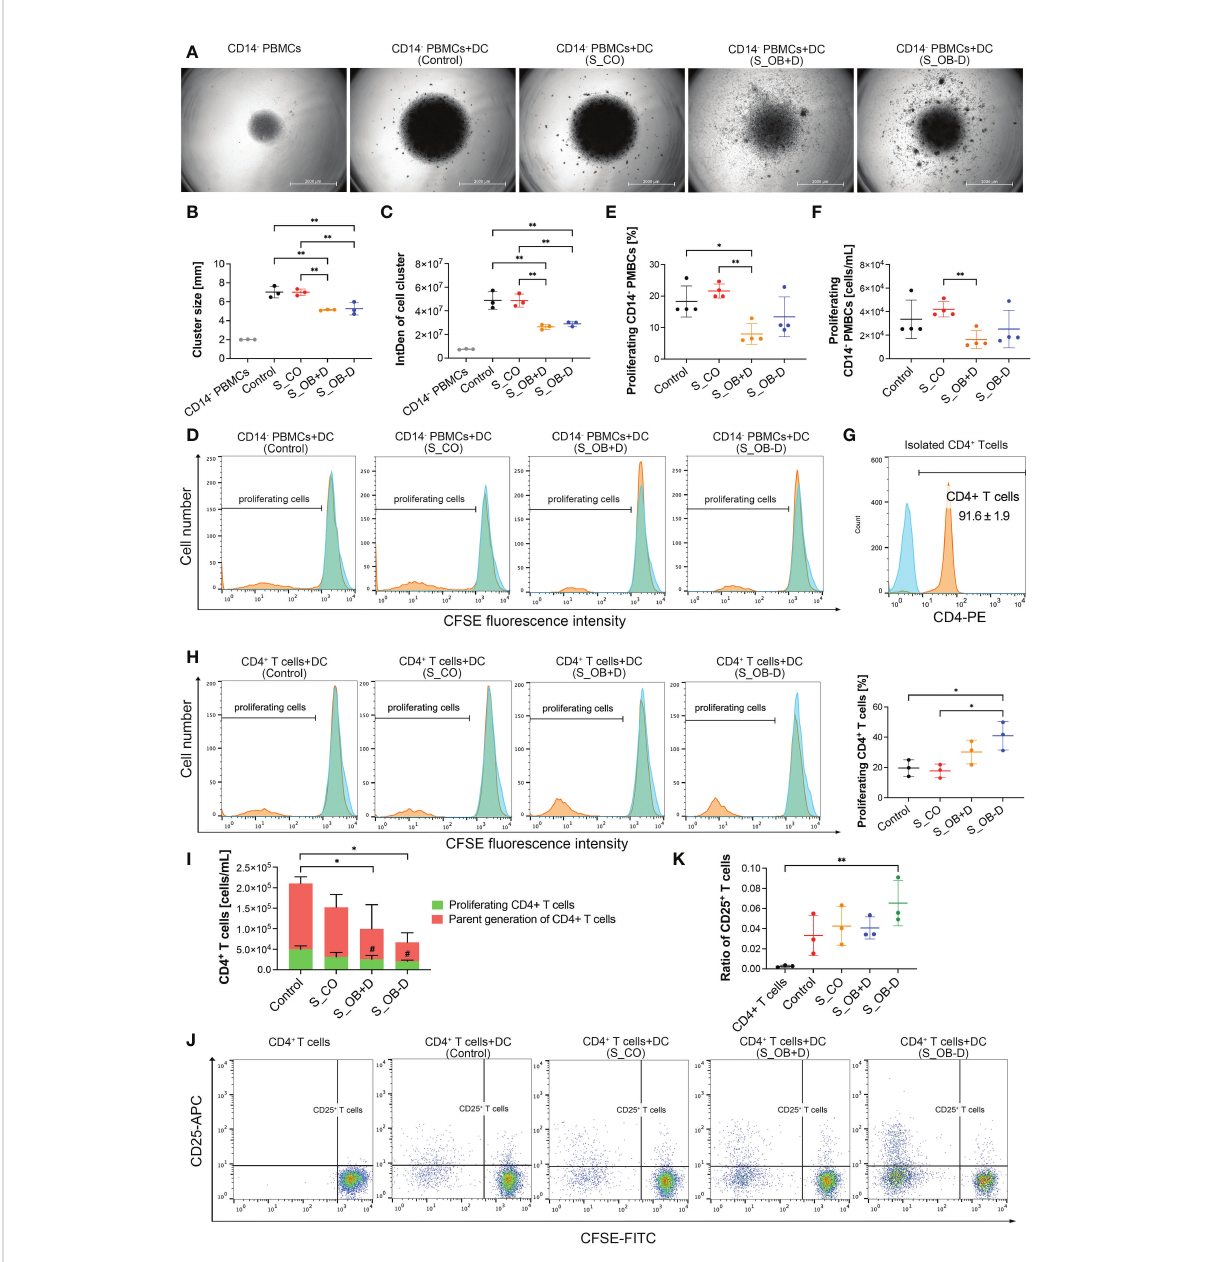
FIGURE 5 Effects of JPC secretomes on lymphocytes stimulatory ability of maturated MoDCs. CFSE-labeled CD14 - PBMCs (A – F) and CD4 + T cells (G – K) were cocultured (ratio 1:1) with MoDCs generated under different conditions (without secretomes (control) or in the presence of 5-fold concentrated